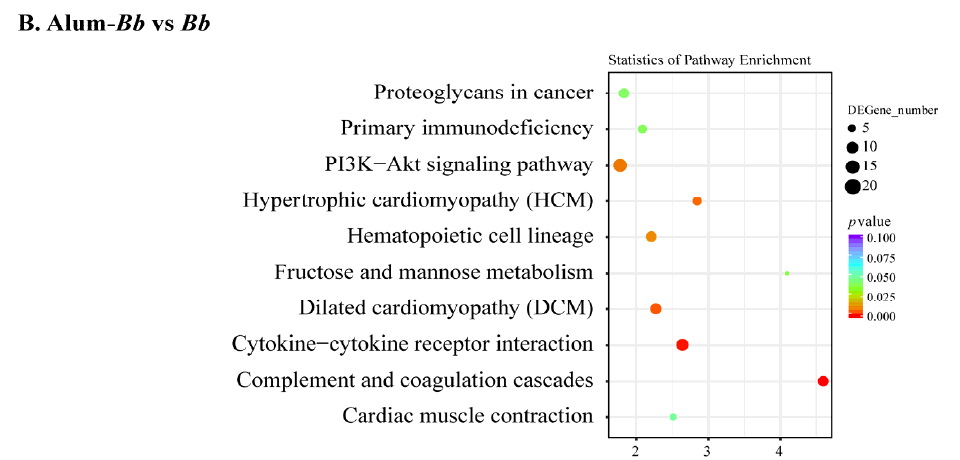
Figure 5. Kyoto Encyclopedia of Genes and Genomes (KEGG) pathway enrichment analysis of DEGs in two comparisons. ( A ) E515- Bb vs. Bb , ( B ) Alum- Bb vs. Bb , and ( C ) E515- Bb vs. Alum- Bb . The X-axis represents the value of the rich factor. The Y-axis represents the enrichment term of the pathway. The size of the dot represents the number of DEGs. The color represents p value.